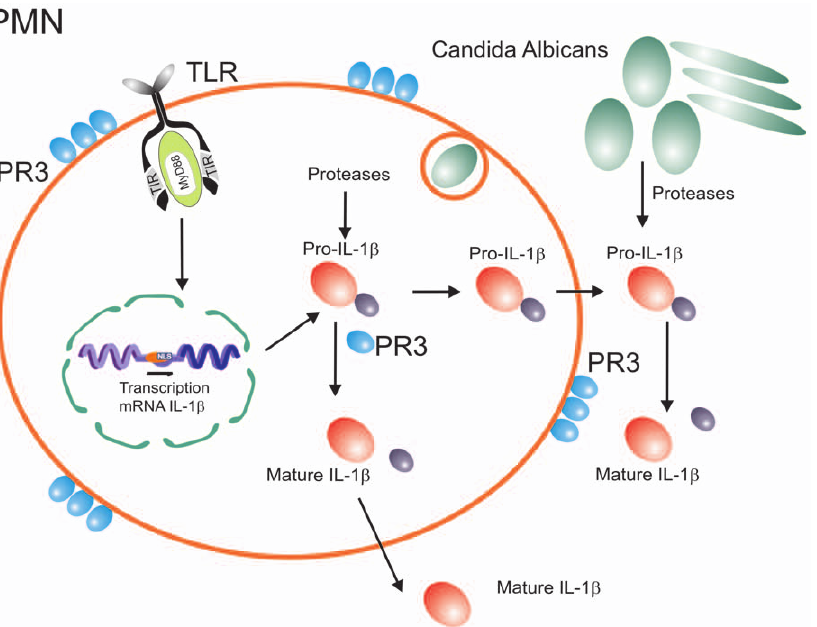
Figure 3. Inflammasome-independent processing of pro-IL-1 b . In addition to caspase-1-dependent activation, pro-IL-1 b can also be processed by neutrophil-derived serine proteases, or pathogen-derived